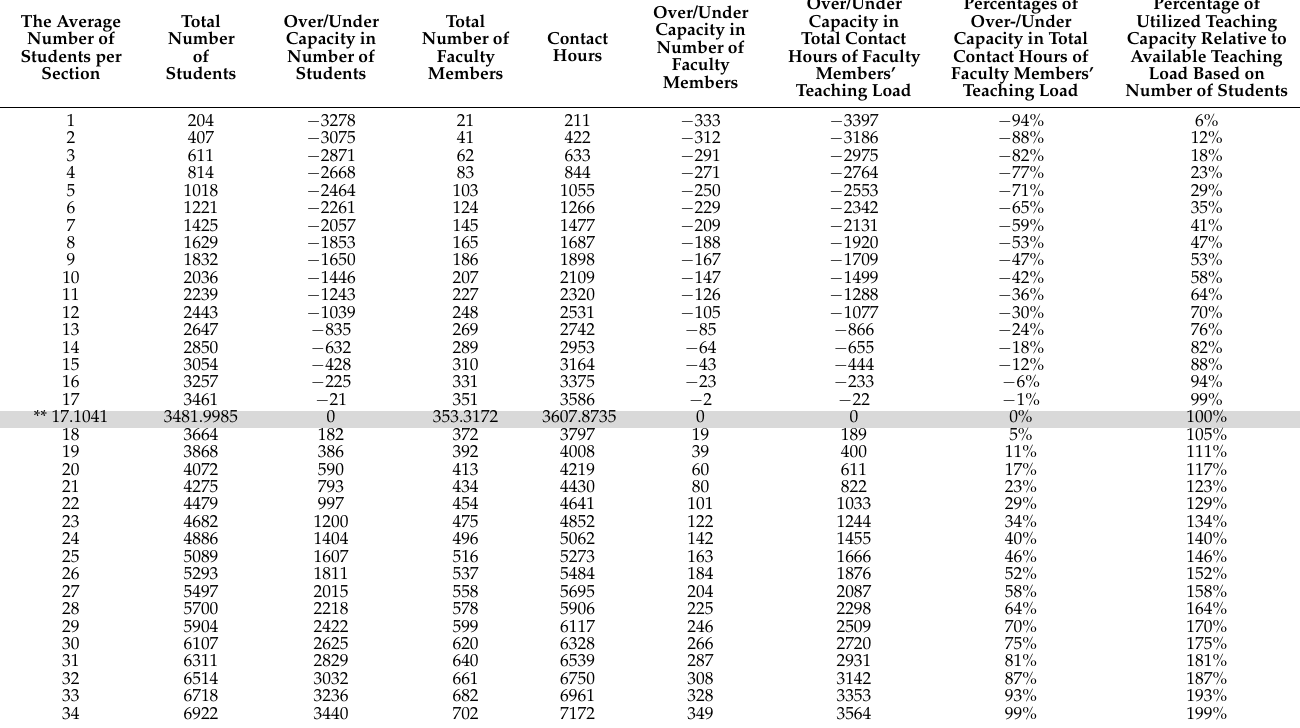
Table 3. Results of the bottom-up model, showing the different cases of utilization levels